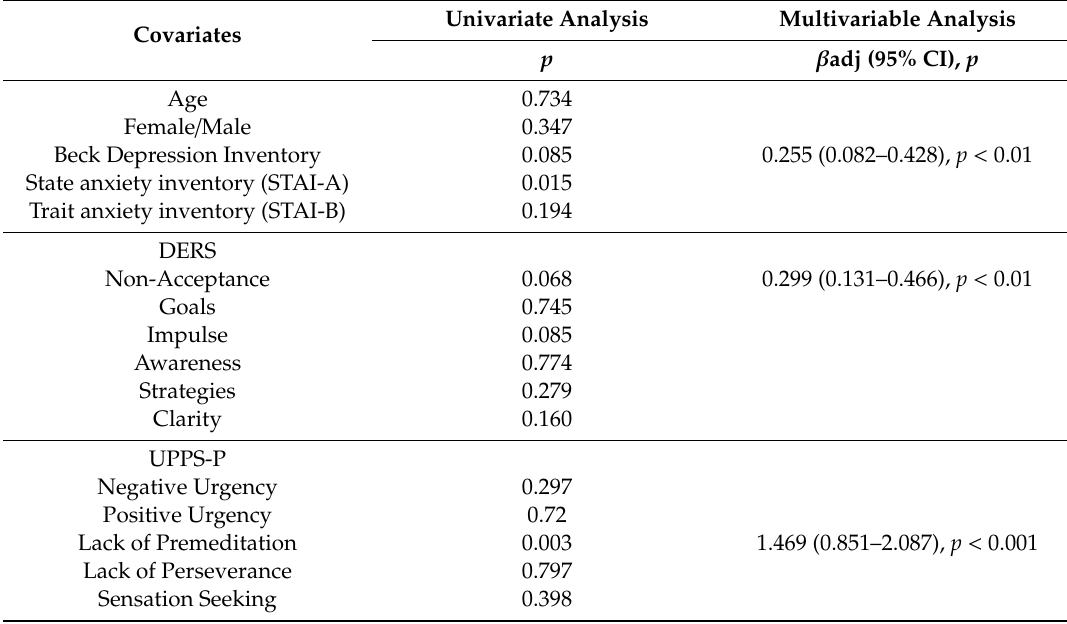
Table 5. Multiple linear regression analysis of the association between BITE subscale (symptom score) and sociodemographic and clinical characteristics in the BED group.